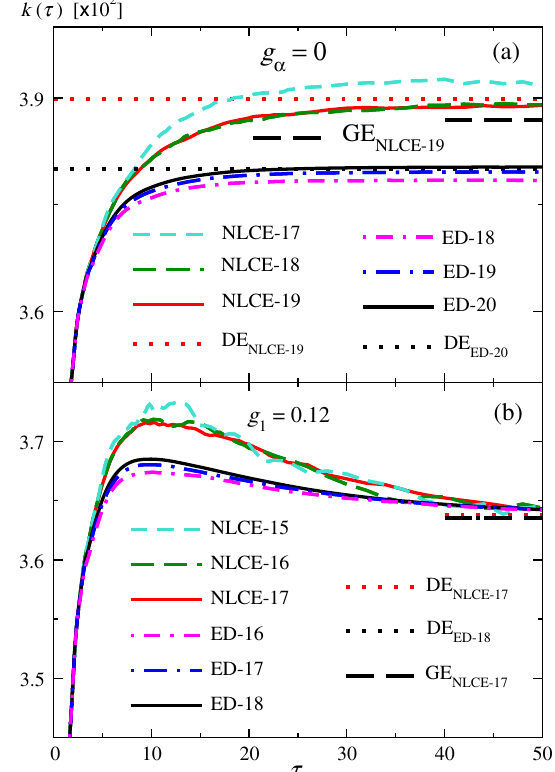
FIG. 11. Time evolution of the one-body nearest neighbor correlation k ð τ Þ obtained in the last three orders l of the NLCE (NLCE- l in the legends), and in the three largest chains with L sites and periodic boundary conditions diagonalized (ED- L in the legends). Results for the diagonal ensemble are shown for the last order of the NLCE (DE ) and the largest chain diagonalized NLCE- l (DE ), while results for the grand canonical ensemble are ED- L shown for the last order of the NLCE (GE ), which are NLCE- l ˆ H → ˆ H converged to machine precision. (a) Quenches 0 , for I l ¼ 17 , 18, and 19 (NLCE-17, NLCE-18, and NLCE-19), and for L ¼ 18 , 19, and 20 (ED-18, ED-19, and ED-20), along with the diagonal ensembles for l ¼ 19 (DE ) and L ¼ 20 NLCE- 19 (DE ), and the grand canonical ensemble for l ¼ 19 ED- 20 ˆ H → ˆ H 0 . 12 , for (GE ). (b) Quenches 1 , in which g 1 ¼ I NLCE- 19 l ¼ 15 , 16, 17 (NLCE-15, NLCE-16, NLCE-17), and for L ¼ 17 , 18, 19 (ED-17, ED-18, ED-19), along with the diagonal ensem- bles for l ¼ 17 (DE ) and L ¼ 18 (DE ), and the grand NLCE- 17 ED- 18 canonical ensemble for l ¼ 17 (GE ). Higher orders in the NLCE- 17 NLCE, and larger chains in exact diagonalization, are calculated in (a) than in (b) thanks to particle-number conservation in the